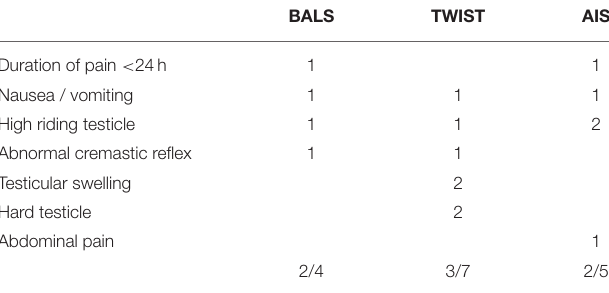
TABLE 1 | Display of the different scoring systems for diagnosing testicular torsion, including the different weighing factors for each